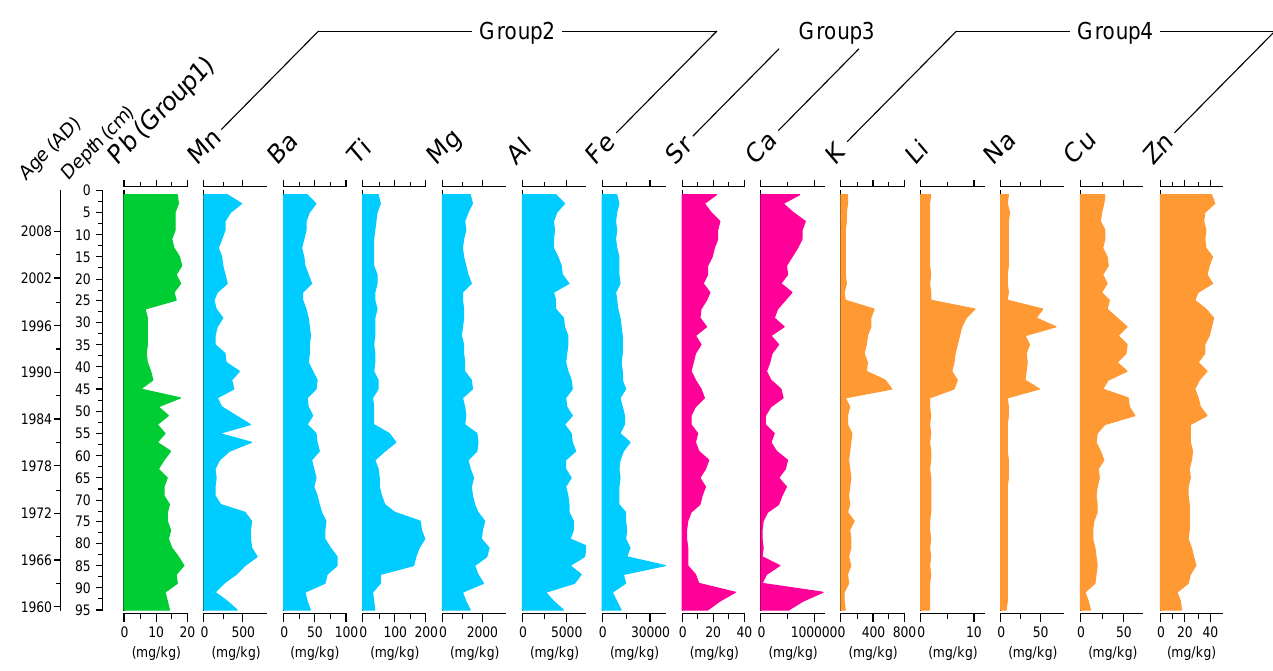
Figure 3. Sediment profiles of 14 weak-acid – leachable elements. The four groups were identified based on cluster analysis results (Figure S1).